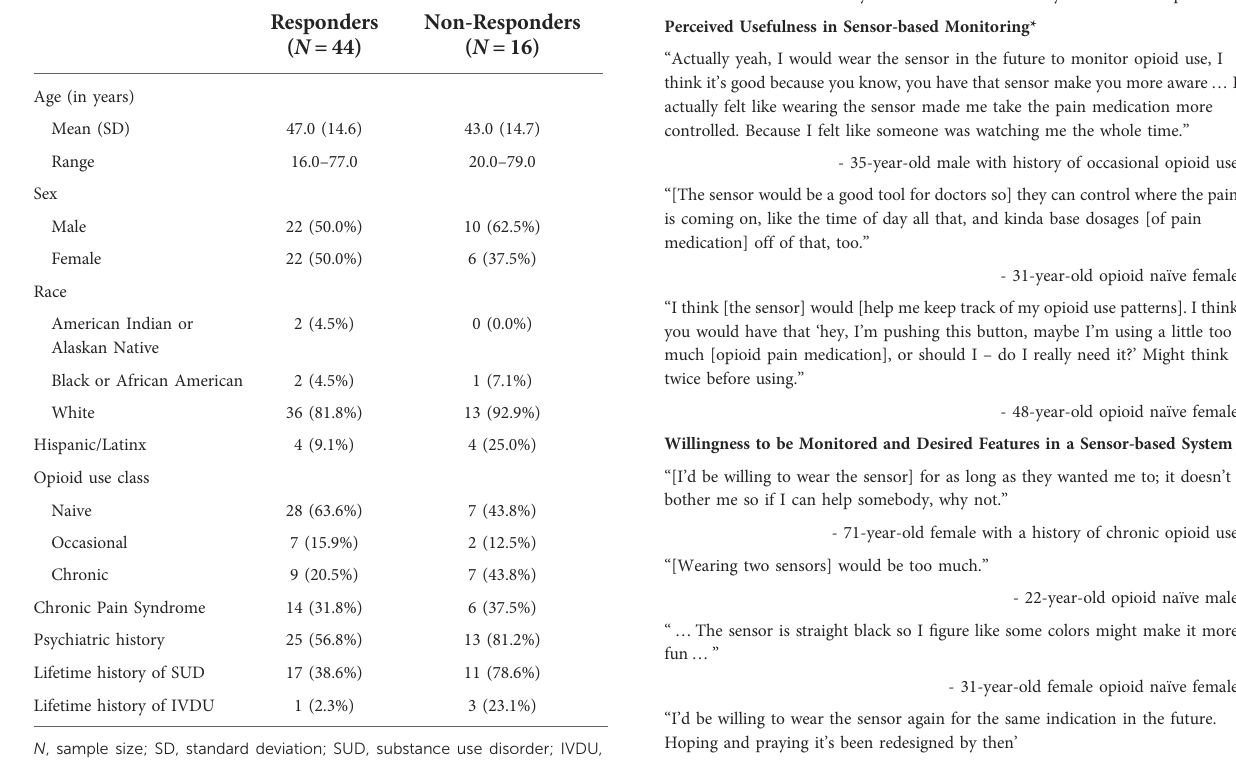
TABLE 1 Demographic data of parent study participants ( N =60) who completed the qualitative interview (responders; N =44) and those who declined to participate (non-responders; N =16).